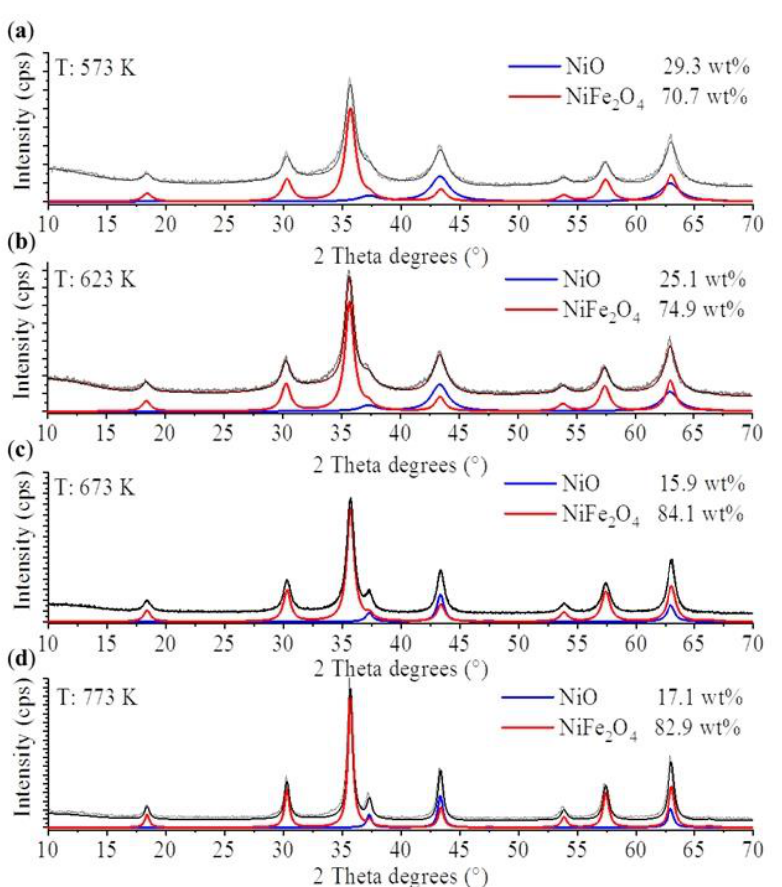
Figure 2. Rietveld refined X-ray diffractograms of the nickel ferrite (NiFe 2 O 4 ) samples formed at different temperatures. ( a ) 573 K, ( b ) 632 K, ( c ) 673 K, ( d ) 773 K.